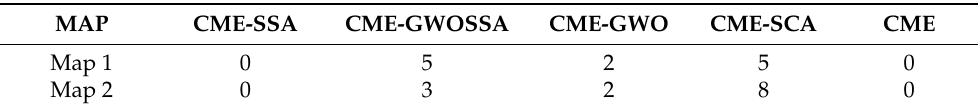
Table 3. The number of failed simulations before completing 100 iterations of exploration on two simple environments (map 1, map 2).